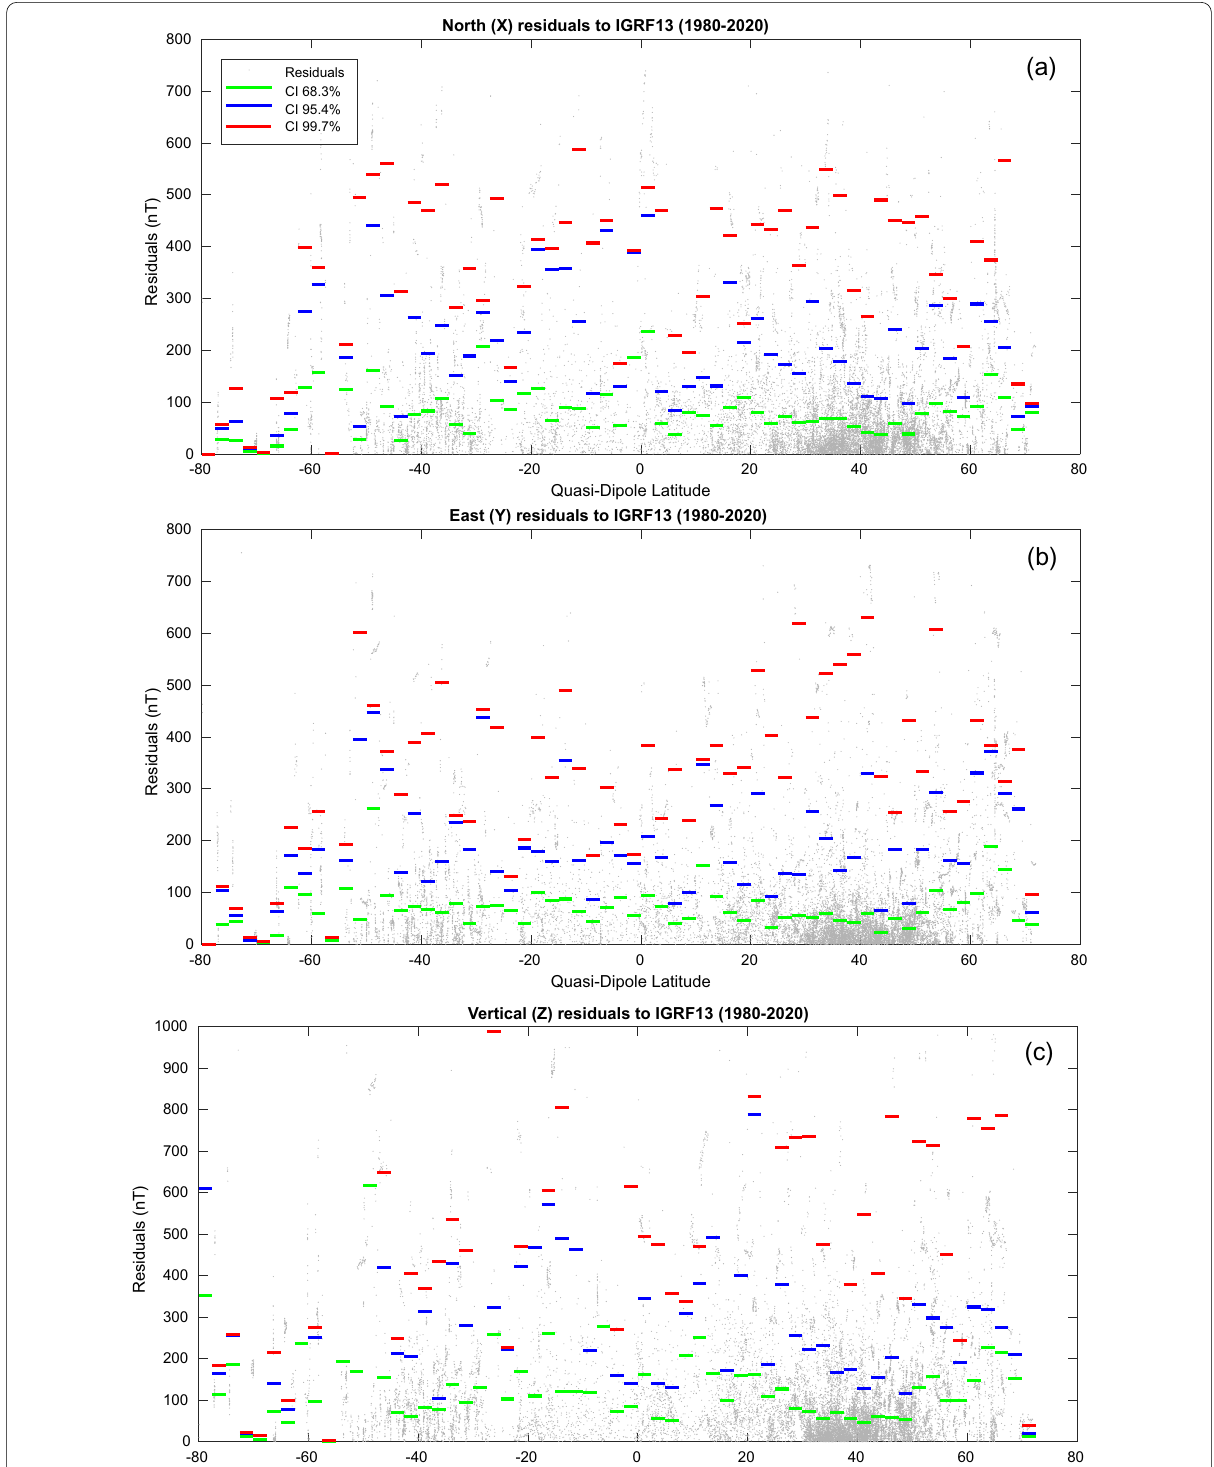
Fig. 4 Residuals plotted against quasi-dipole latitude (gray dots) for a North (X), b East (Y), and c vertical (Z) field. The residuals are divided into bins of 2.5 ◦ latitude and the 68.3, 95.4 and 99.7% confidence intervals are computed (colored